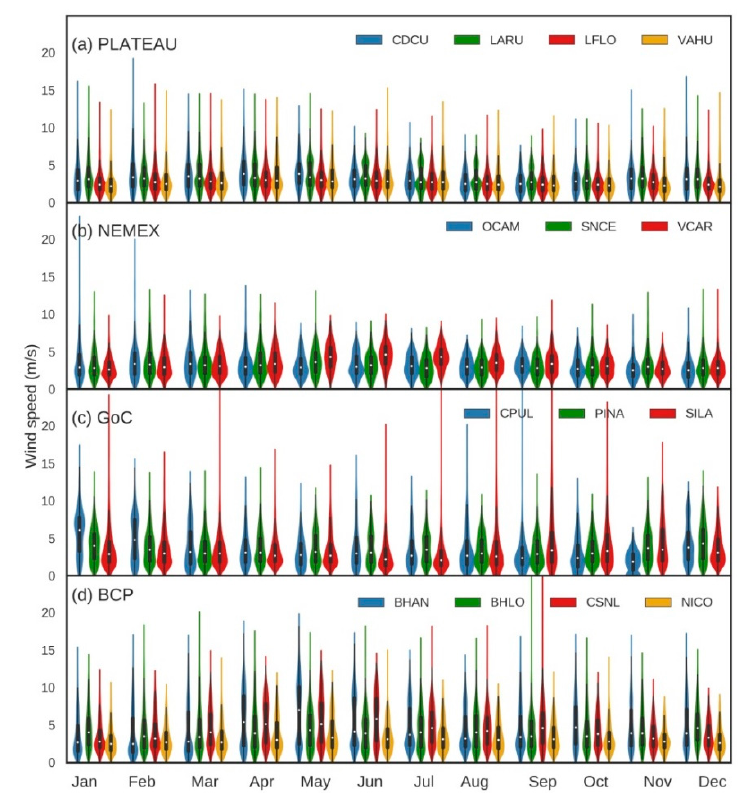
Figure 7. Violin plots of monthly 10 m wind speed for ( a ) Plateau, ( b ) NEMEX, ( c ) GoC, ( d ) BCP. Violin plot include a white point for the median of the data and a box indicating the interquartile range. Whiskers indicate variability outside the first and third quartile and below 1.5 times interquartile range. Outliers extend out the whiskers. Distribution of the data is shown by a kernel distribution [52].